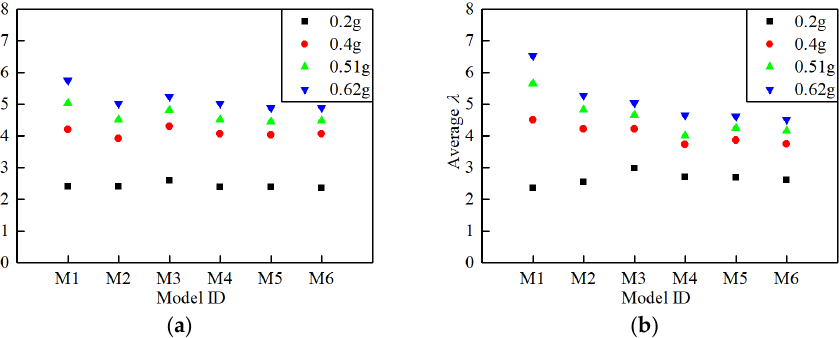
Figure 17. The average λ of columns across the slope direction on the 1st floor: ( a ) Axis 1; ( b ) Axis